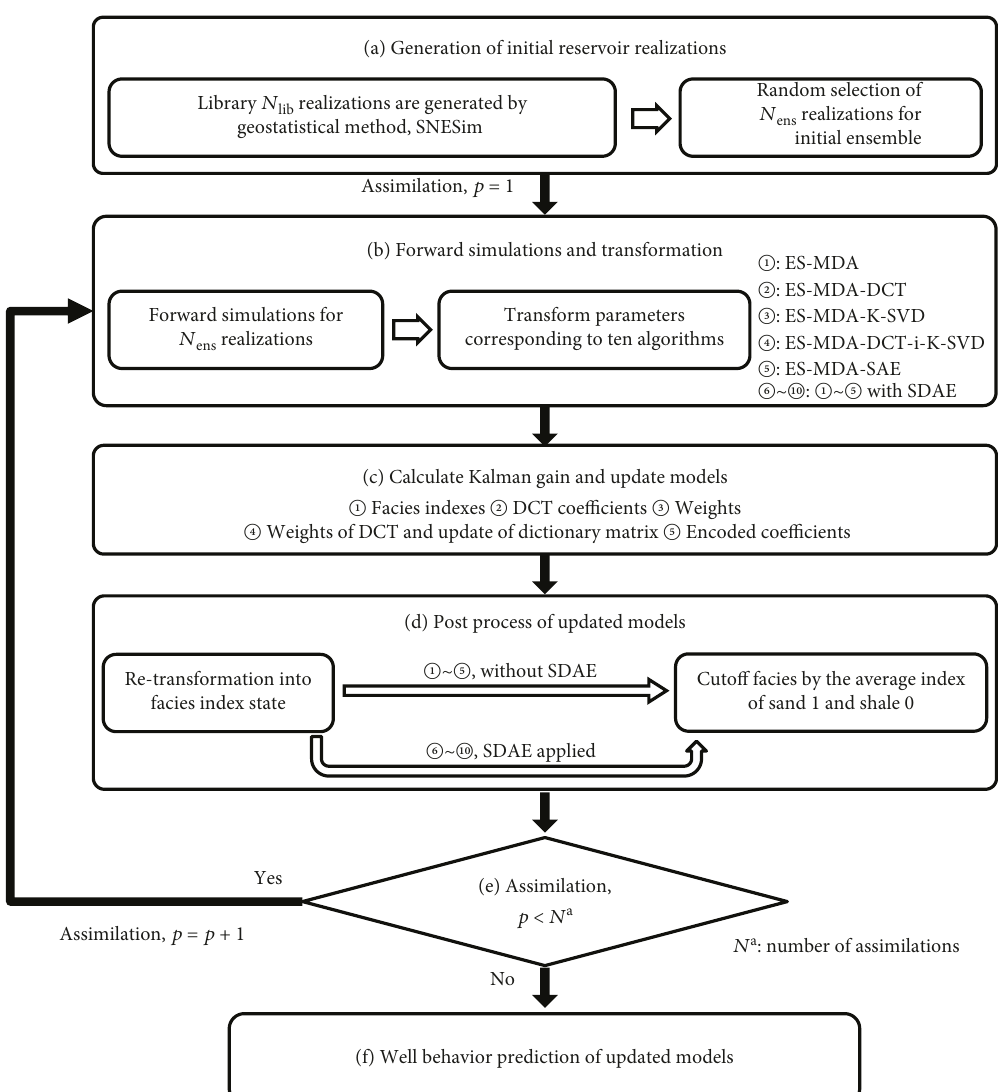
Figure 9: Flowchart of ten ES-MDA algorithms conducted in this